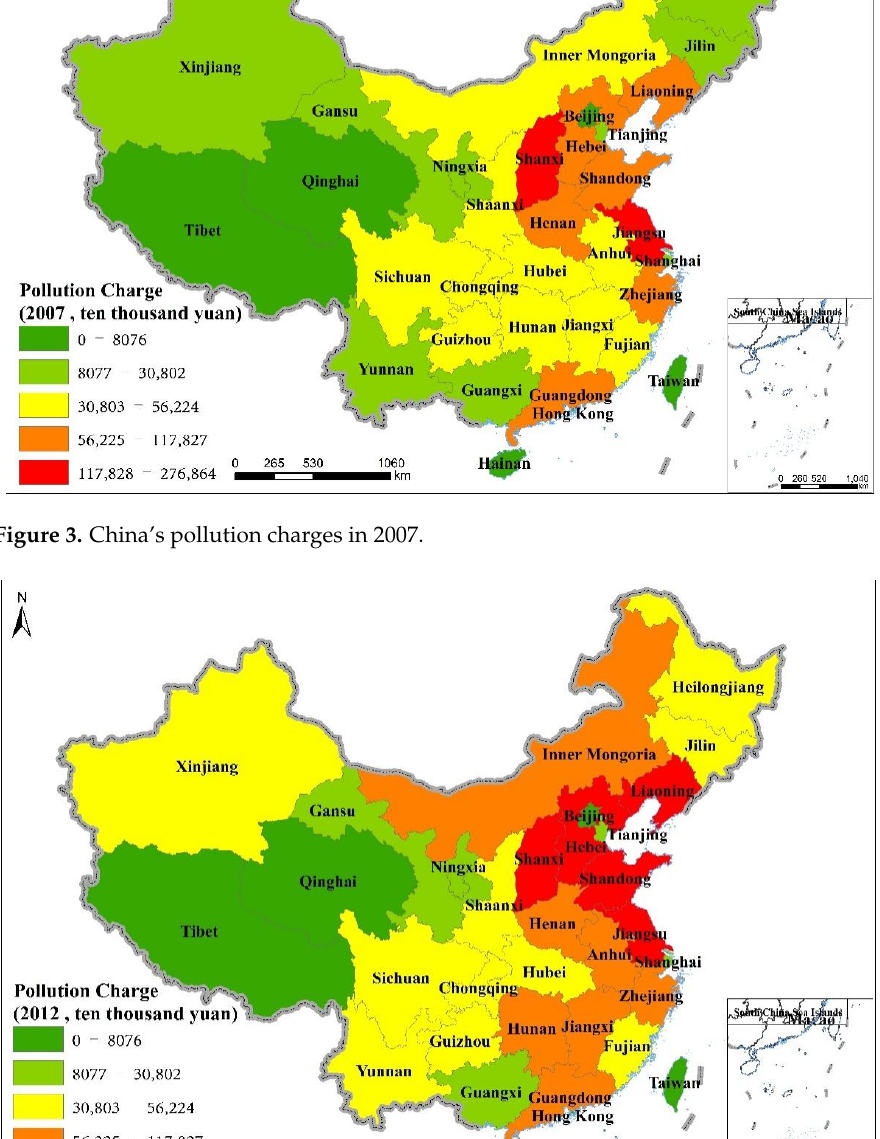
Figure 4. China’s pollution charges in 2012.